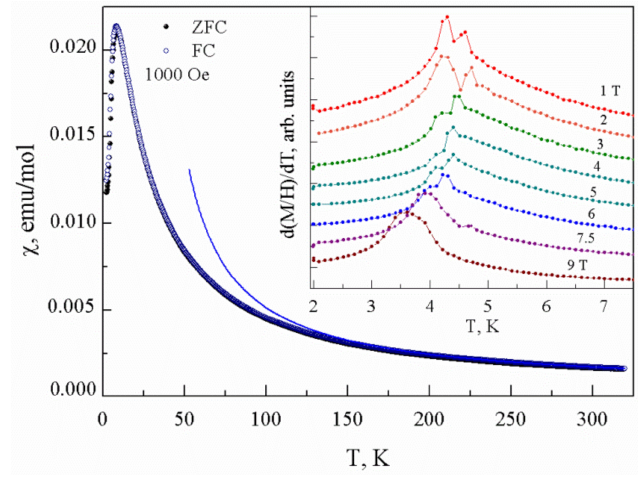
Figure 2. Temperature dependences of magnetic susceptibility χ in PbCu(SeO 4 )(OH) 2 taken at µ 0 H = 0.1 T in both FC and ZFC regimes. Inset: d χ / dT curves taken at various magnetic fields. The field dependence of magnetization M in a pulsed magnetic field taken at 2.4 K is shown in Figure 3. This curve is normalized by the M ( H ) curve taken in the static magnetic field at the same temperature. The saturation at the level of 1 µ B is reached at µ 0 H flip ~ 16 T. It is preceded by a jump at µ 0 H flop = 2.4 T. The anomalies at spin-flop and spin-flip transitions are pronounced in the field dependence of derivative dM/dH, as shown in the inset to Figure 3. An additional small anomaly can be identified at µ 0 H ~ 19 T.